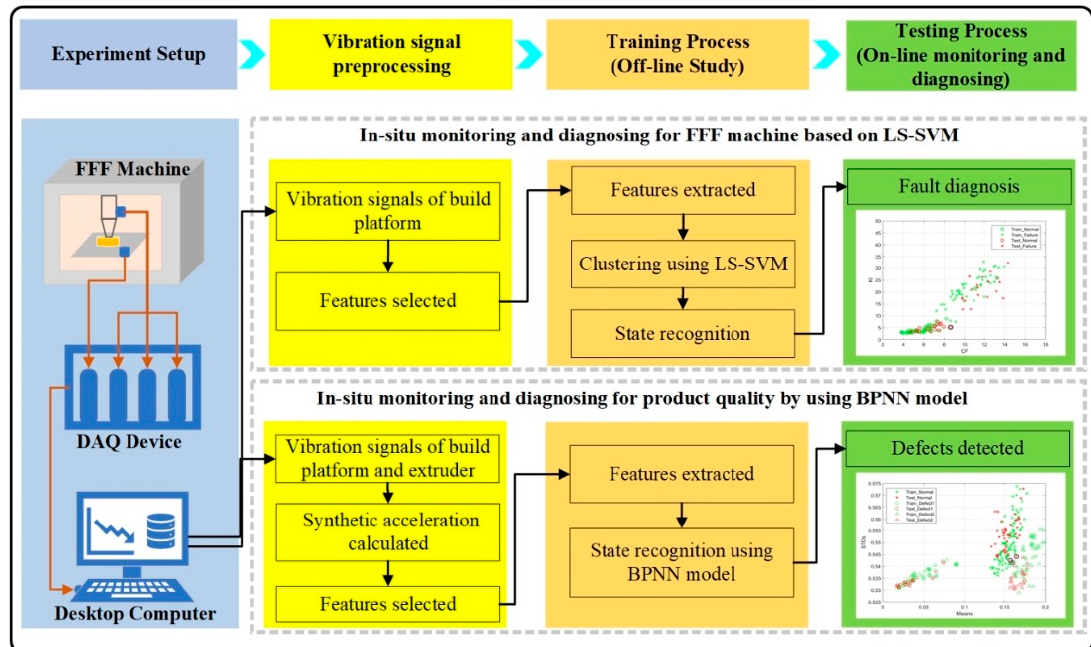
Figure 1. The flowchart of in-situ monitoring and diagnosing for fused filament fabrication (FFF) process. BPNN: back-propagation neural network; LS-SVM: least squares support vector machine; DAQ: data acquisition.